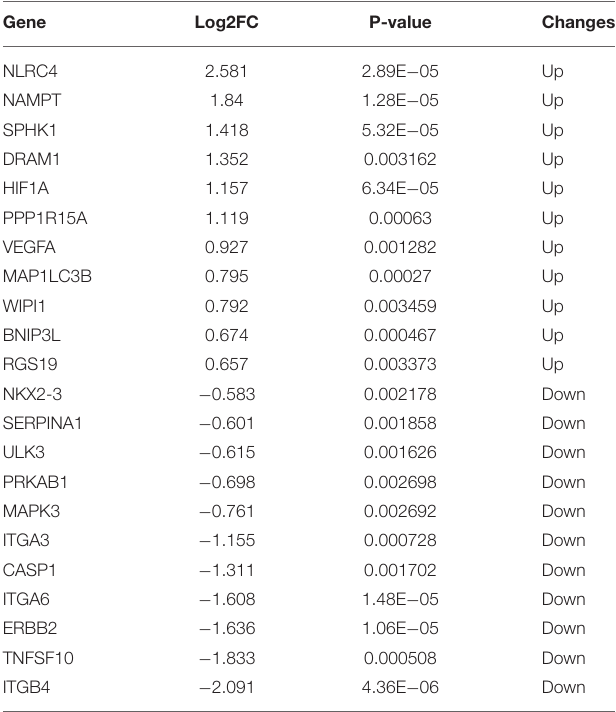
TABLE 2 | The 22 differentially expressed autophagy-related genes in human NEC derived from dataset